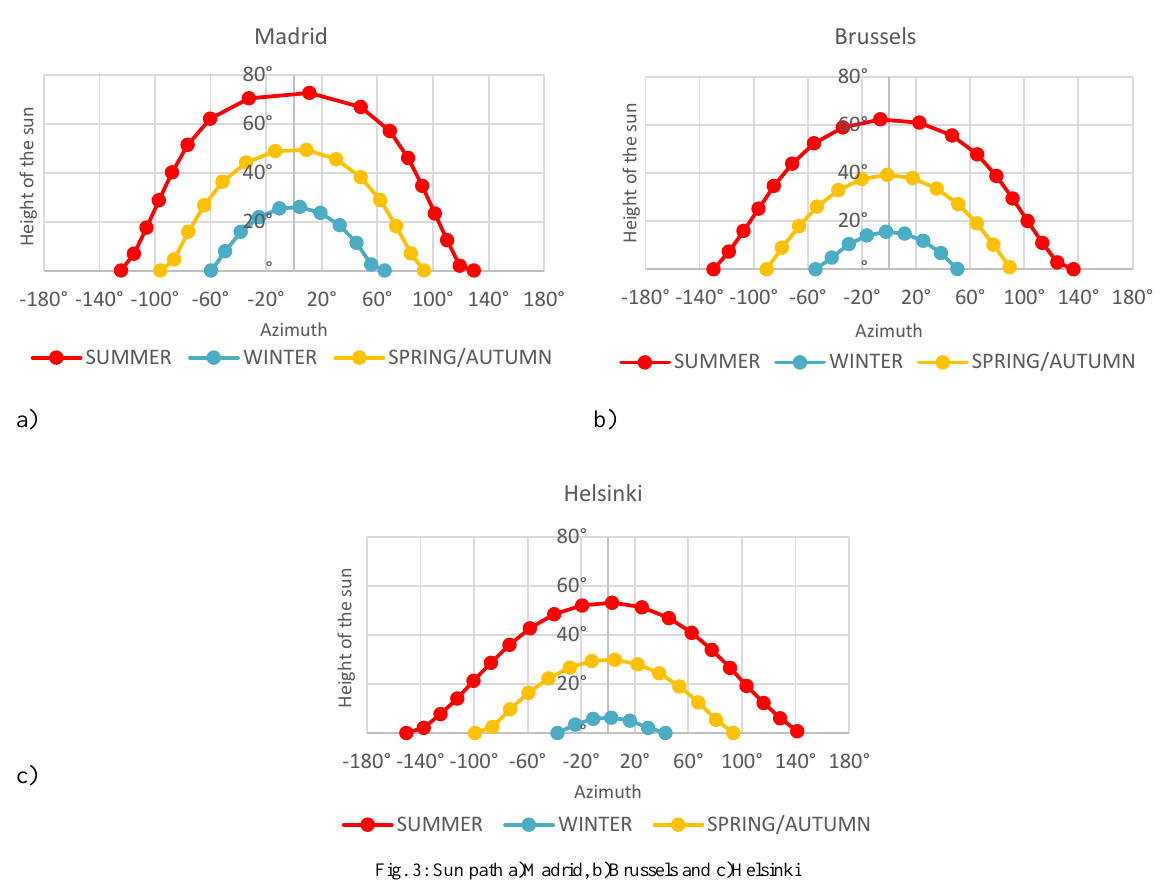
Fig. 3: Sun path a)Madrid, b)Brussels and